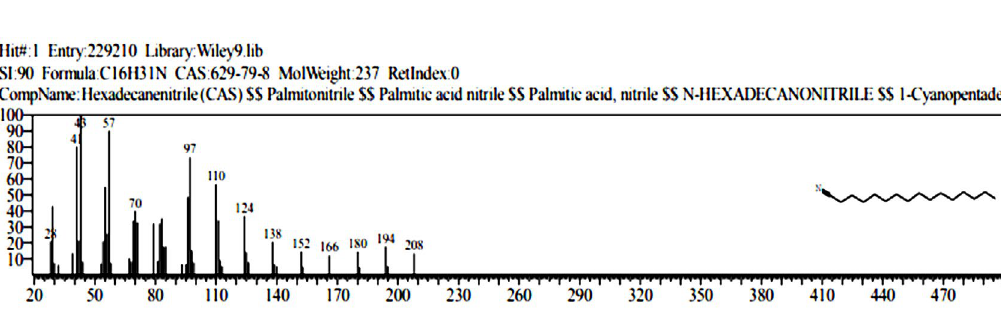
Fig. 13. The chromatogram of chemical compounds Hexadecanenitrile(CAS) Palmitonitrile, Palmitic acid nitrile, N-Hexadecanonitrile, 1-Cyanopentadecane